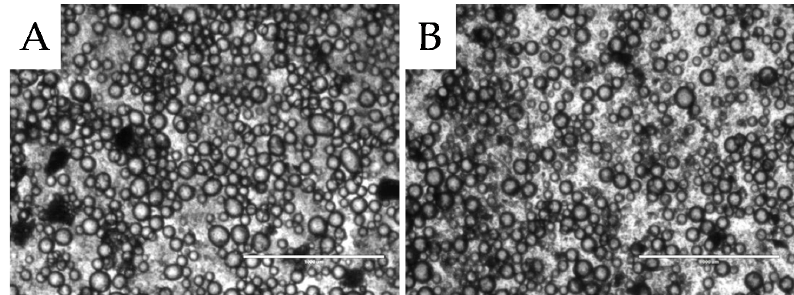
Figure 5. Light micrographs of o/w emulsions stabilised with 8% milled waste coffee Pickering particles and sunflower oil as the oil phase (46%) before heating ( A ); and after heating ( B ) the emulsion to 80 °C. Scale bar represents 1000 μ m.